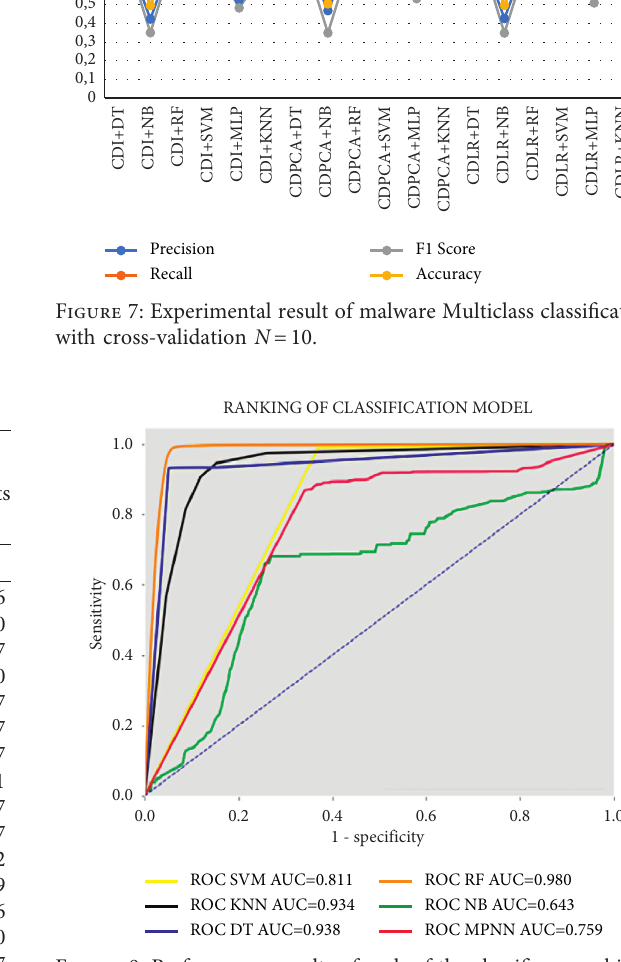
Figure 8: Performance results of each of the classifiers combined with the 13 features obtained by the logistic regression